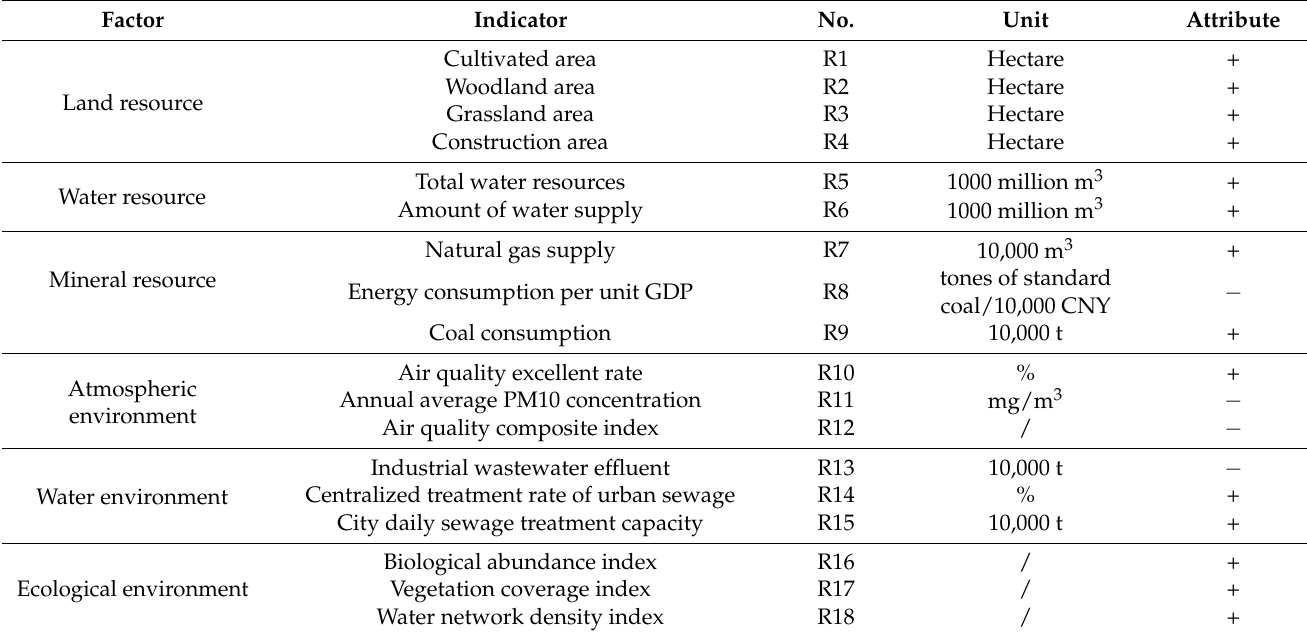
Table 1. Resources and environment carrying capacity (RECC) evaluation